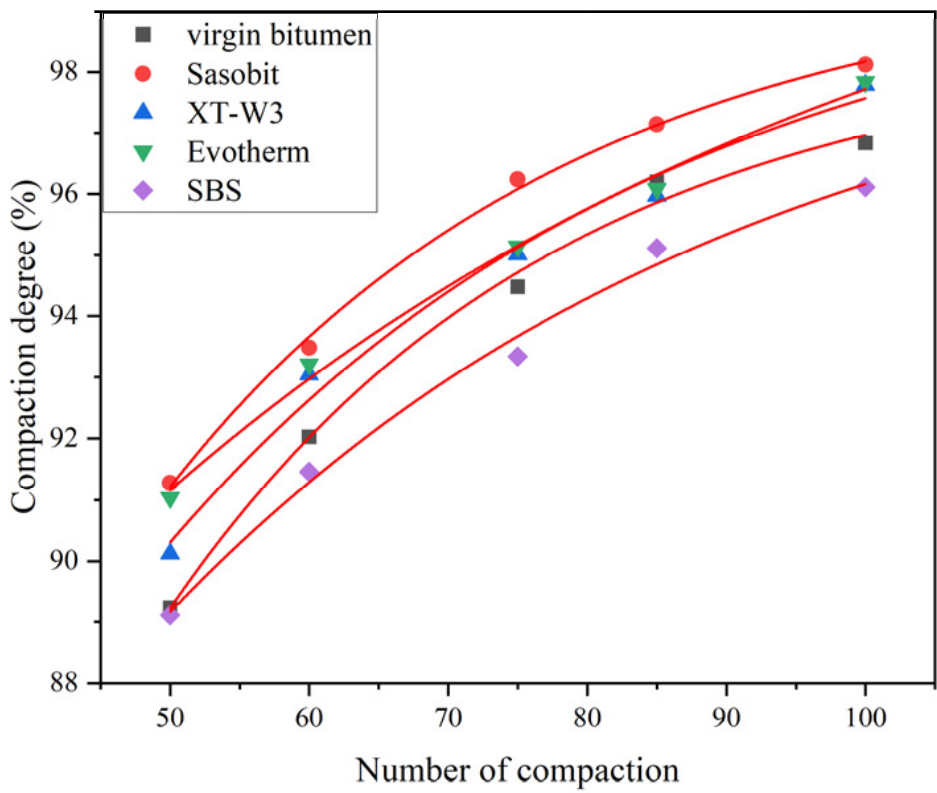
Figure 10. Relationship between compaction degree and number of compactions.